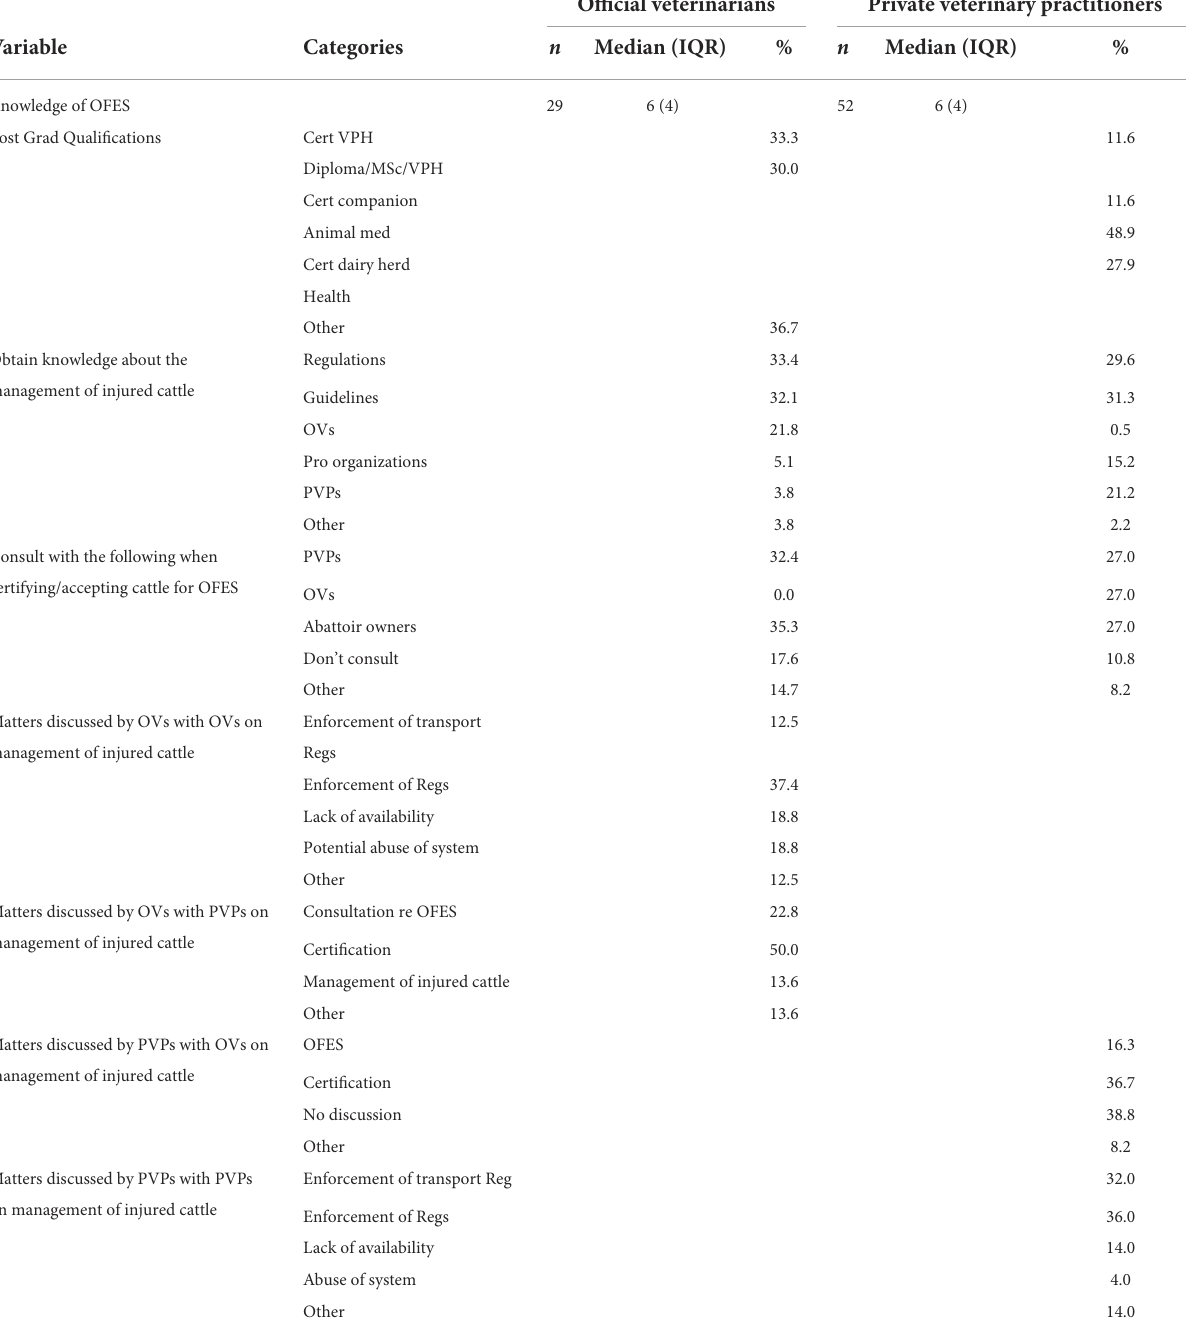
TABLE 2 Factors influencing the Capacity/Knowledge of Official Veterinarians and Private Veterinary Practitioners regarding the management of acutely injured cattle in